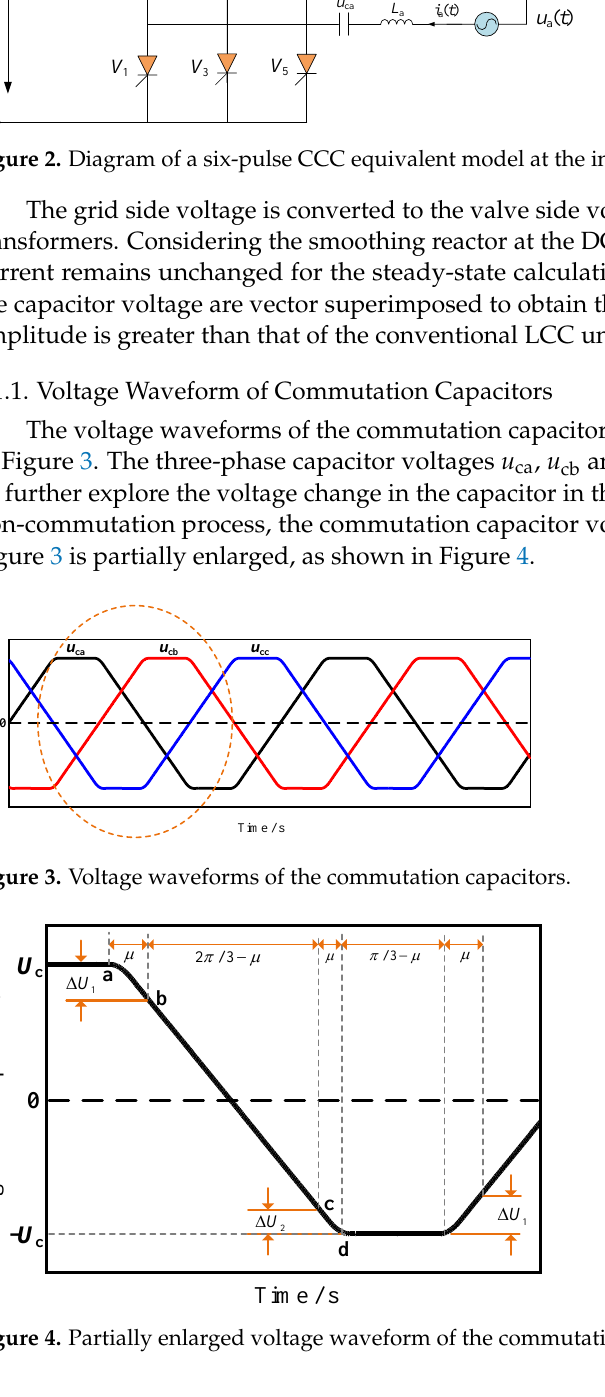
Figure 4. Partially enlarged voltage waveform of the commutation capacitor in phase A. In Figure 4, curve ab represents the commutation process from valve 2 to valve 4, and the corresponding capacitor voltage drops from U c to U c − △ U 1 . Straight line bc indicates